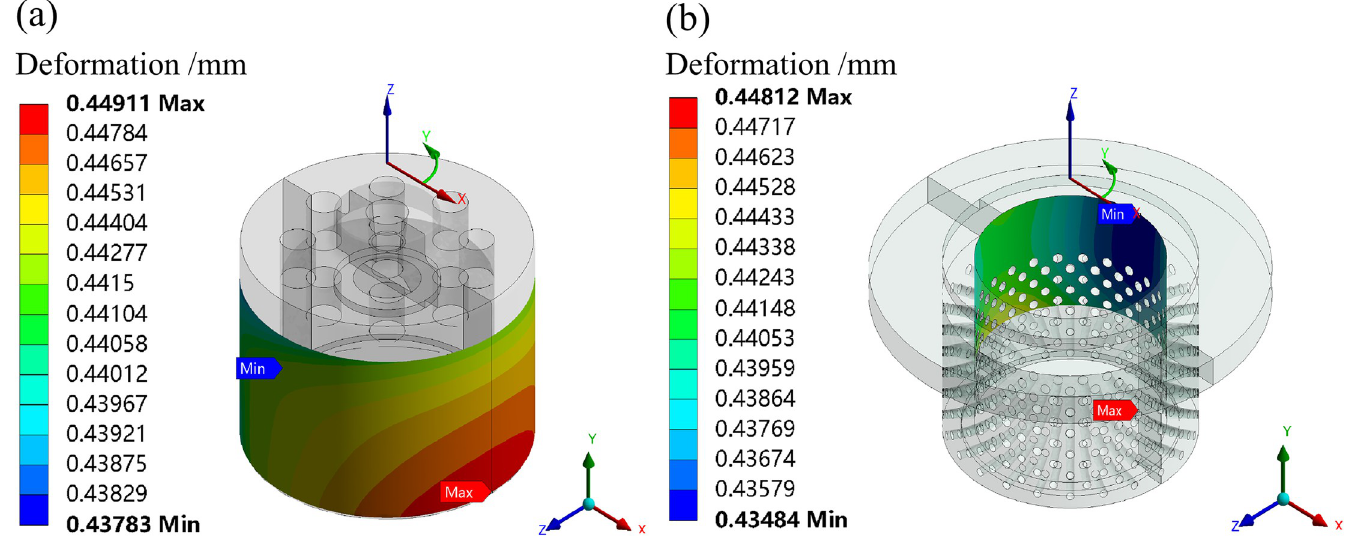
Fig 6. Radial deformation of the matching surfaces at a 50% opening. (a) Valve plug. (b) Inner sleeve.